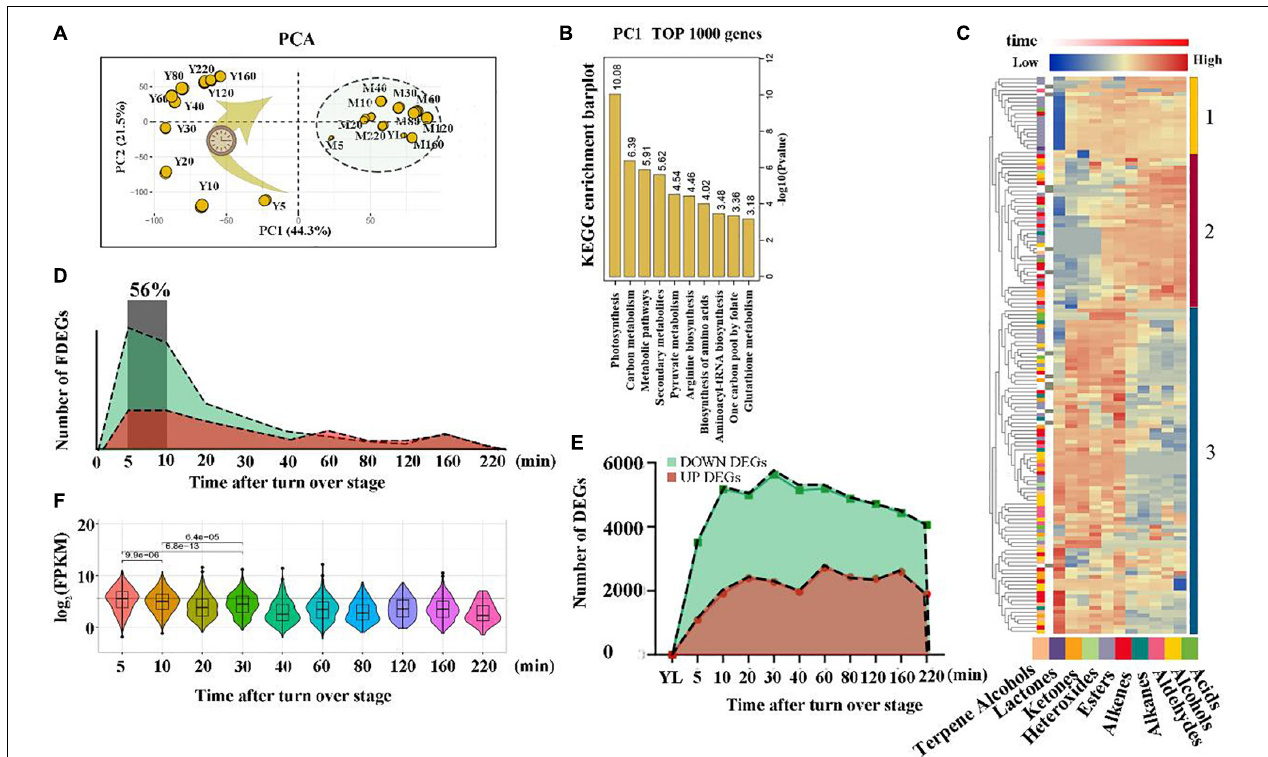
FIGURE 1 | Overview of a time course of metabolome and transcriptome data. (A) RNA-seq score plot of a principal component analysis (PCA). The size of the yellow circle represents their contribution values to the principal components. (B) KEGG enrichment analysis of the top 1000 genes in PC 1 (the most 1000 differential expressed genes between all wounding time points vs. all non-wounding time points). Yellow columns indicate the p -value of the top 10 significantly enriched pathways. (C) Heat map of metabolic profiles. The peak value of each metabolite was normalized [log2 (peak area + 1)] to complete the linkage hierarchical clustering. Red indicates high abundance. The different color blocks on the left side of the heat map represent different types of wounding-induced volatiles; the different color blocks and number on the right represent different clusters. (D) The number of FDEGs of an area chart. FDEGs: The gene was differentially expressed for the first time at a specific time point. Green indicates down-regulated genes, whereas red indicates up-regulated genes. (E) The number of DEGs in an area chart. Green indicates down-regulated genes, whereas red indicates up-regulated genes. (F) Violin plot of FDEG expression distribution at each time point. The expression of each FDEG was normalized using log2